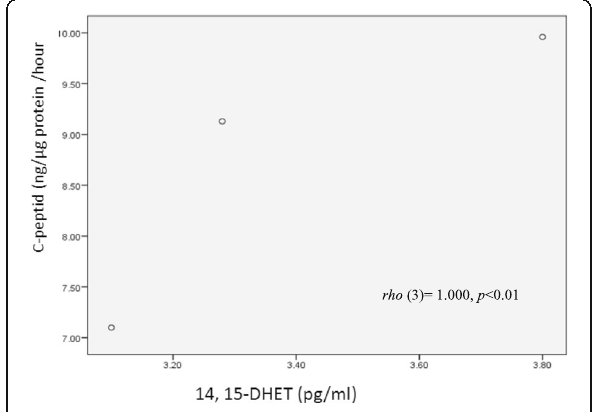
Fig. 3 Spearman correlation between 14, 15 EET concentrations and C-peptide amount released from differentiated IPCs incubated